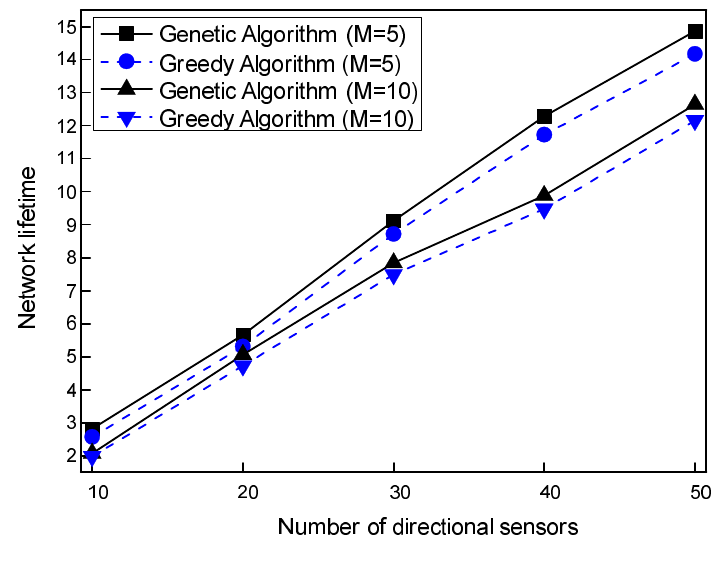
Figure 6. Comparison of network lifetimes according to the number of directional sensors.